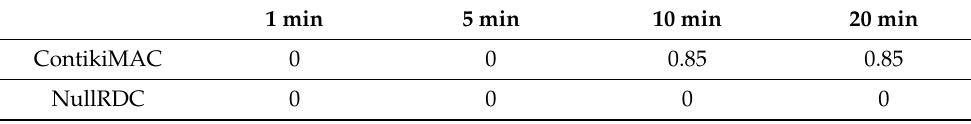
Table 3. One sender one receiver—packet drop rate